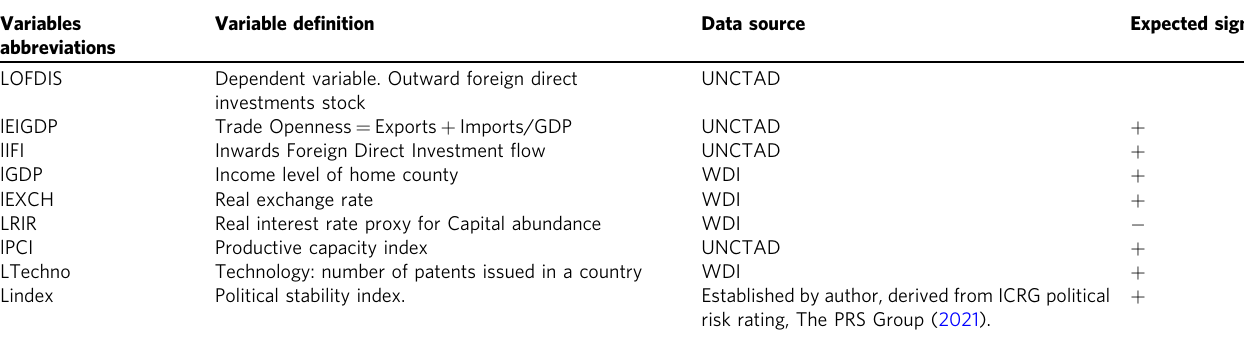
Table 1 Variable de fi nitions and